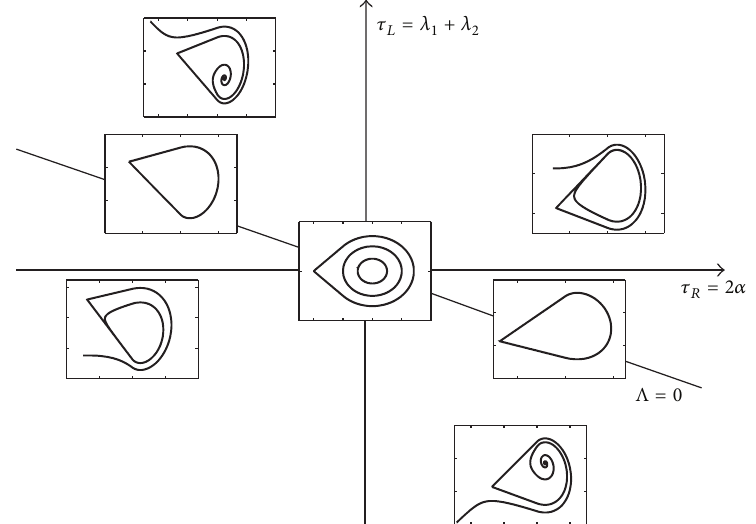
Figure 8: A bifurcation diagram.